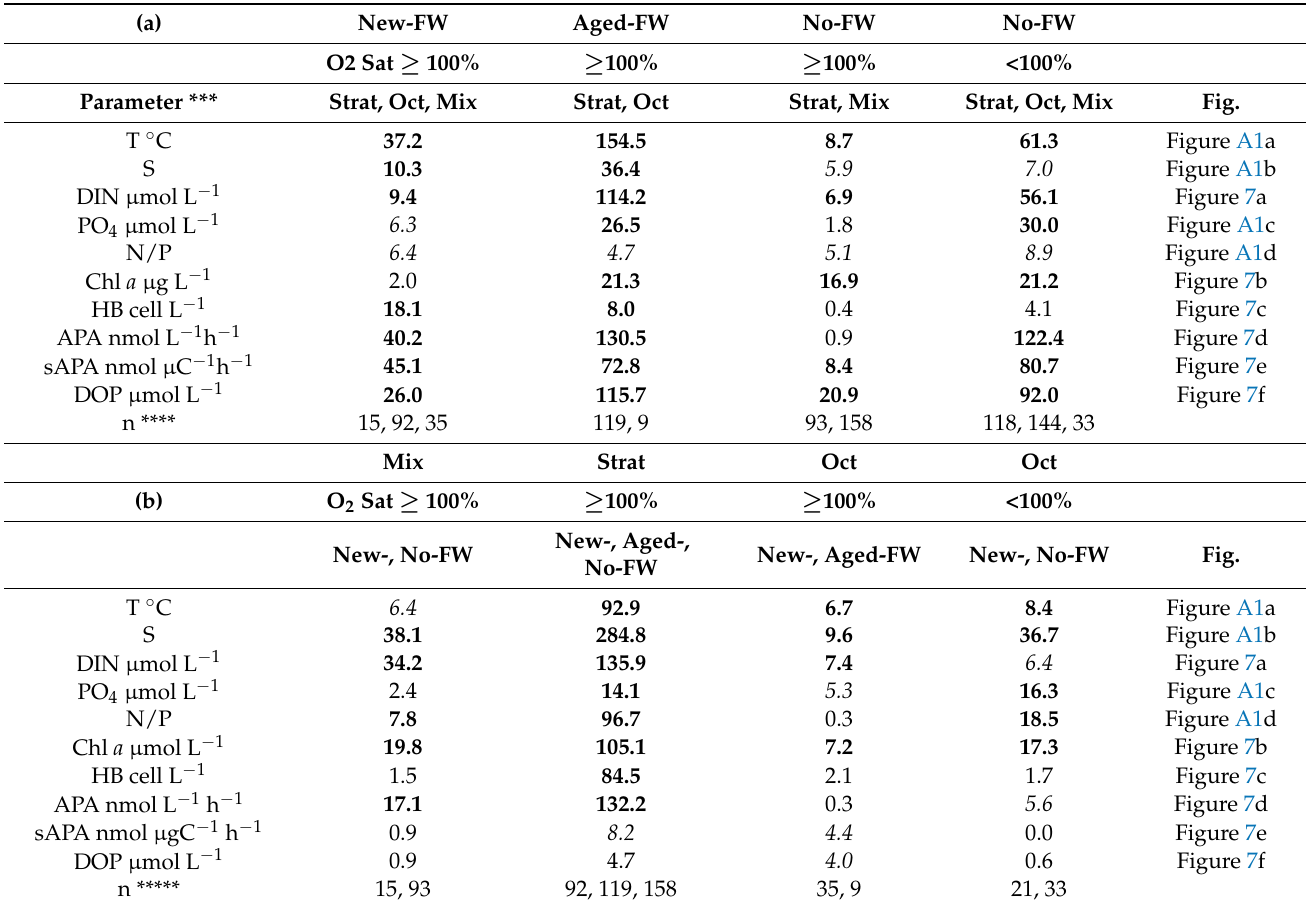
Table A1. Comparison of parameters in ( a ) different water types * by period ** and ( b ) in different periods by water type using nonparametric Kruskal–Wallis H test. Reported H values are bolded when significant at p < 0.01, in italic when significant at p < 0.05, and in grey when not